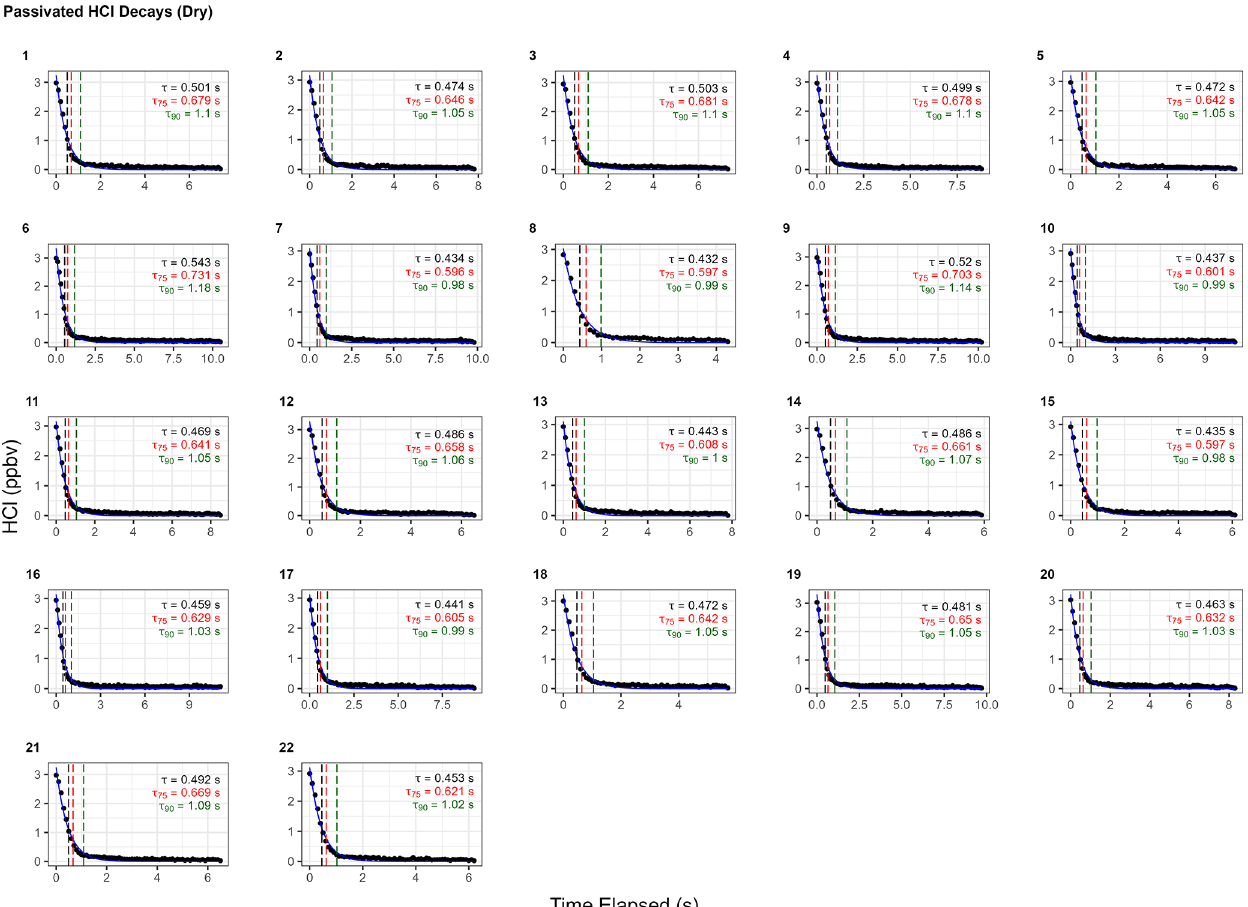
Figure A4. Instrument response times to changes in HCl mixing ratios with active chemical passivation and a high-flow inertial inlet (12.7Lmin − 1 ) . Black dots represent observed data and are overlaid by the calculated single exponential model (according to the terms listed in Table A3). Vertical hashed lines are placed on time elapsed corresponding to τ e (black), τ 75 (red), and τ 90 (green).